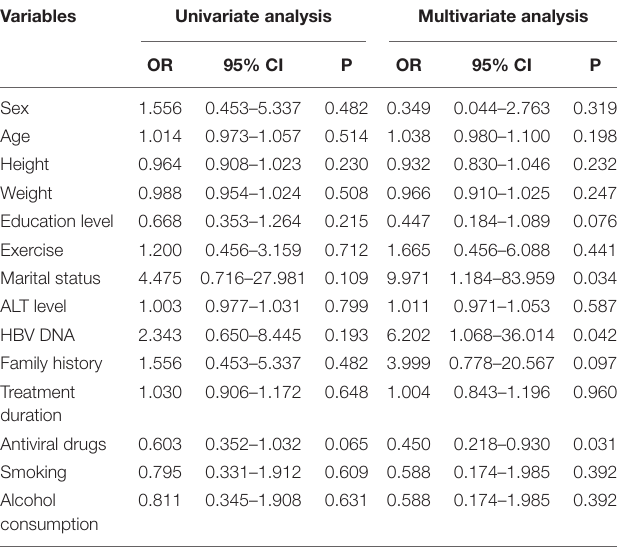
TABLE 3 | Multivariable analysis for physiological quality of life.